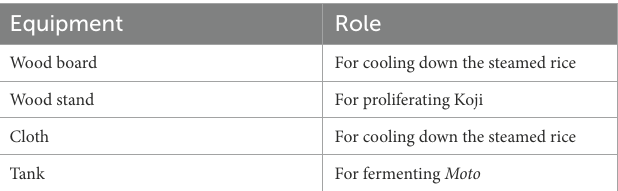
TABLE 1 The roles of each piece of equipment surveyed in this